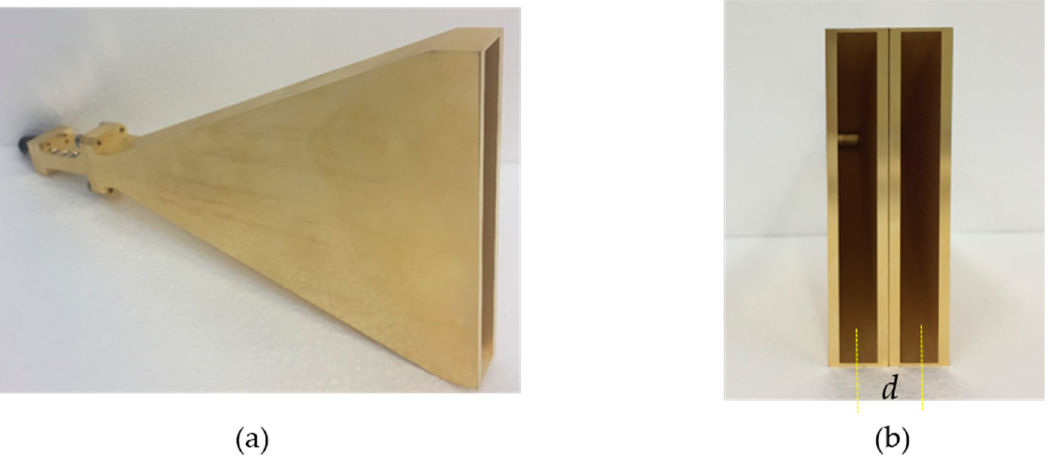
Figure 6. Illustration of the Rx antennas, ( a ) the implemented E-plane sectoral horn antenna; ( b ) two-element Rx antenna array with the distance d between the centers of the individual antennas. Sensors 2018 , 18 , x FOR PEER REVIEW